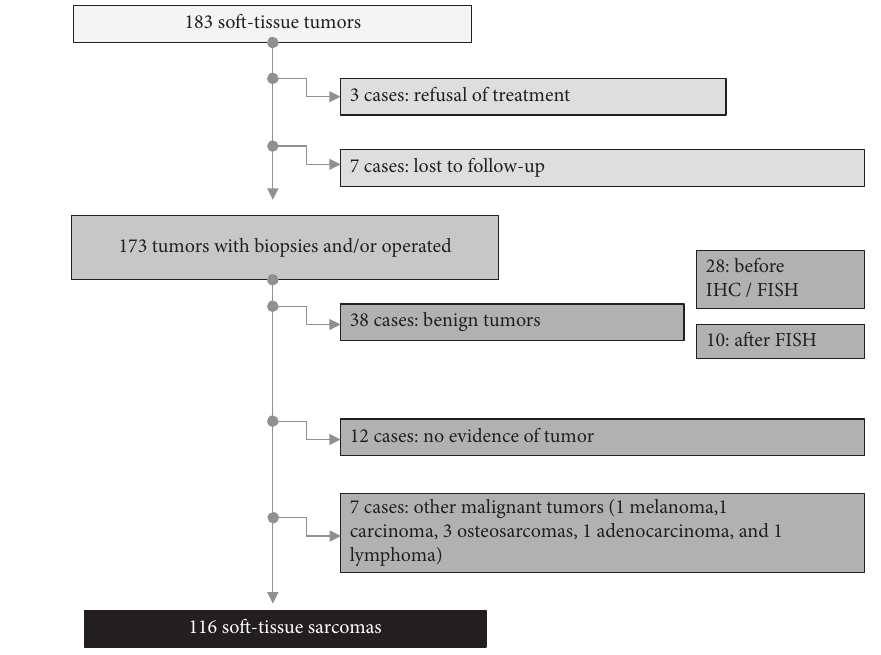
Figure 1: Flowchart of the study. Table 1: Description of the